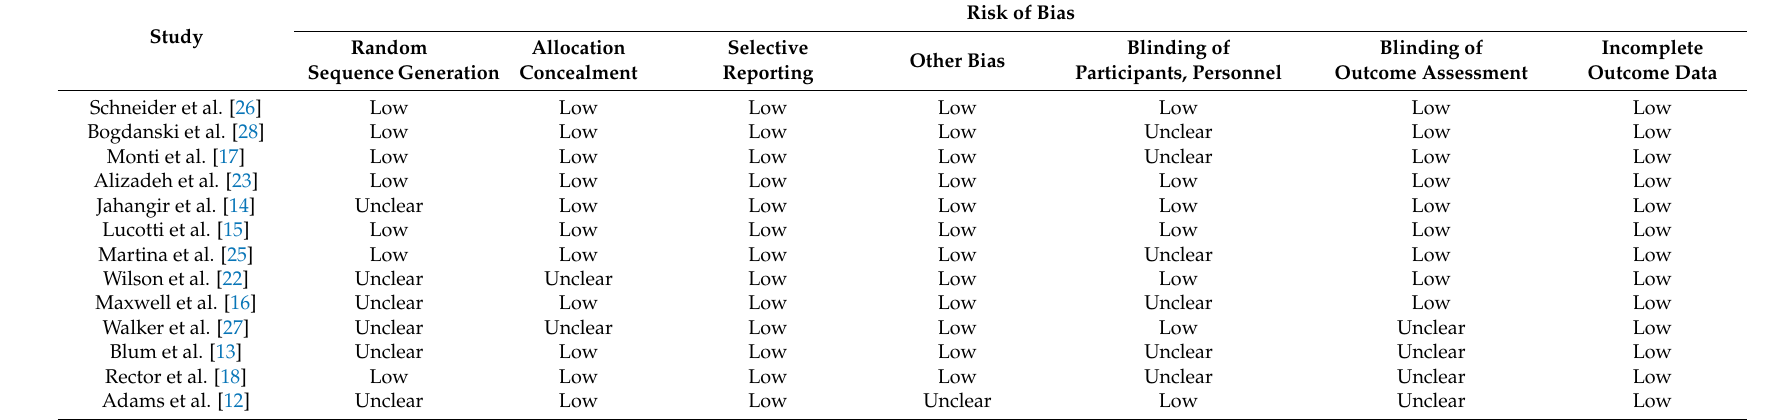
Table 2. Risk of bias of individual